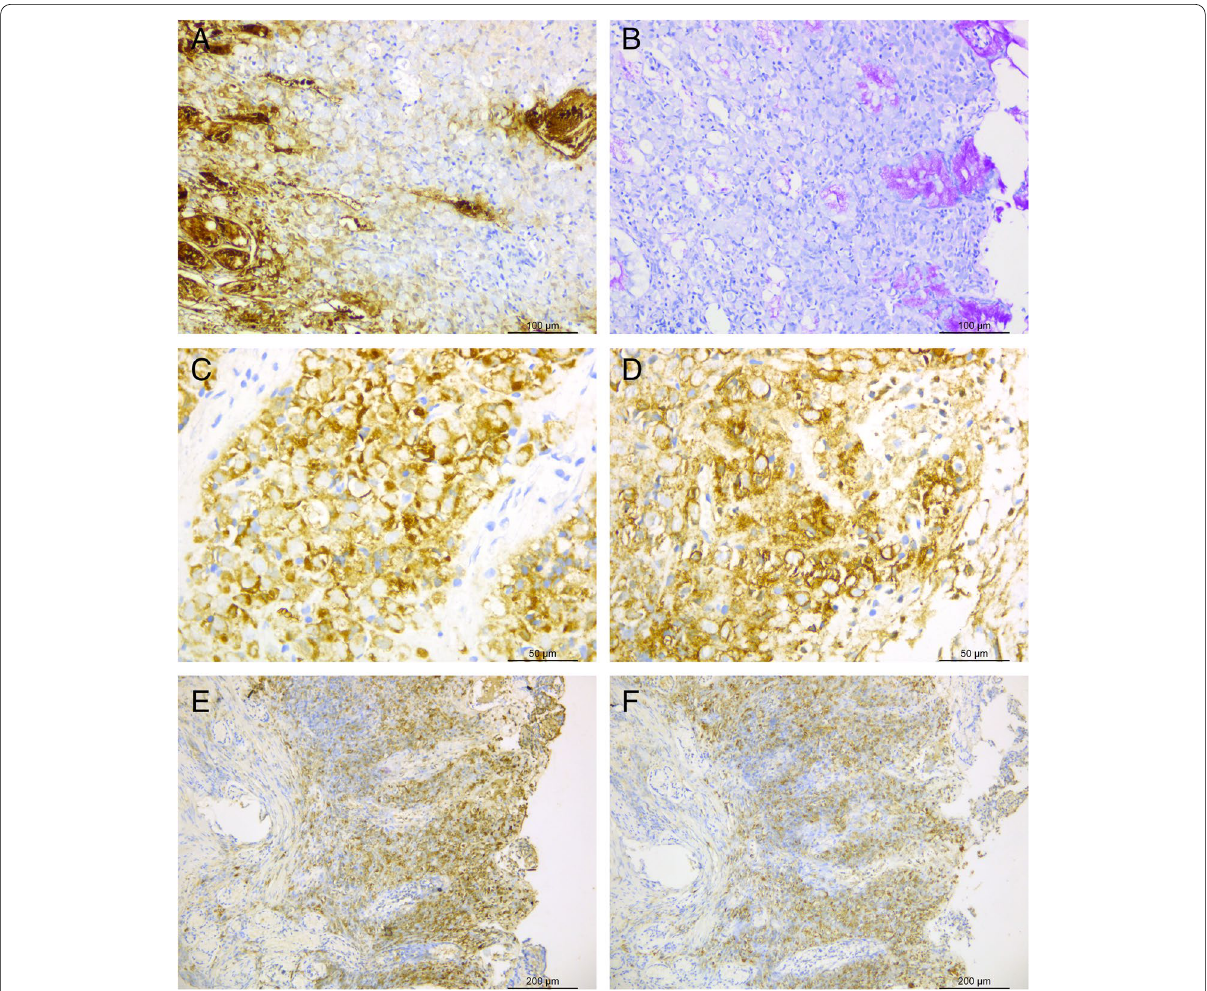
Fig. 3 Immunohistochemical stains in mimics signet ring cells negative (initial biopsy). A : CK(-); B : PAS(-); C : CD79a( (κ) ( ); F:Lambda (λ) ( ++ ++